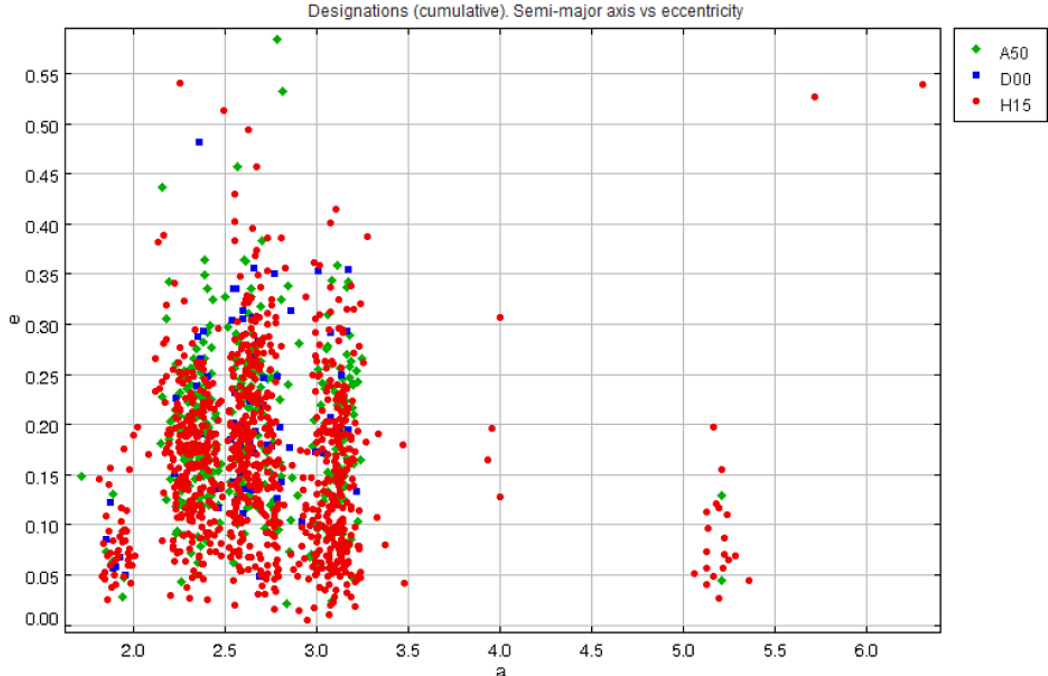
Figure 8. Distribution of asteroids discovered with ISON by orbital elements (semi-major axis/inclination). Discoveries related to different observatories are highlighted in color (MPC code A50 - green, D00 – blue and H15 – red). Vertical axis –values of semi-major axis, horizontal –value of inclination.